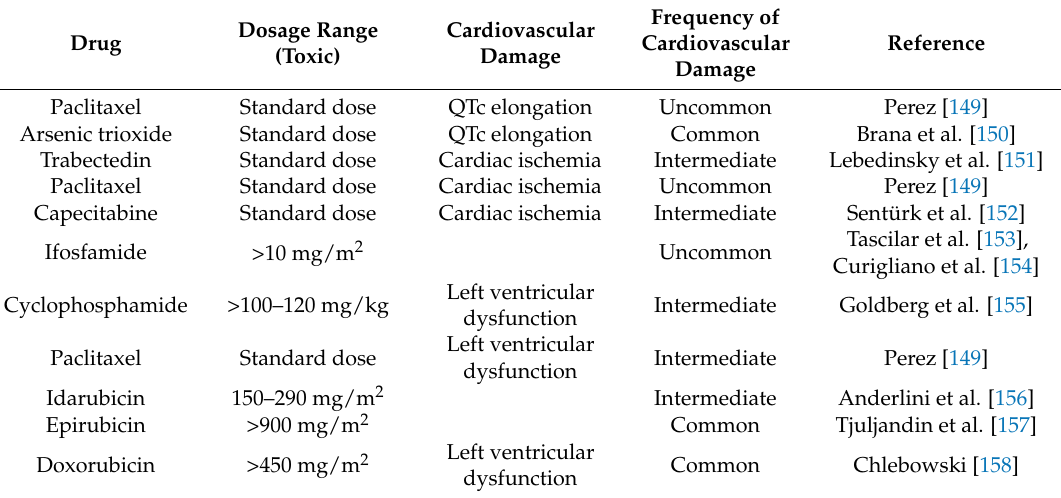
Table 2. Risk and incidence of chemotherapeutic derived cardiovascular